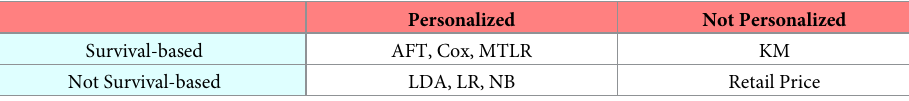
Table 5. Different approaches to set prices. Personalized Not Personalized Survival-based AFT, Cox,